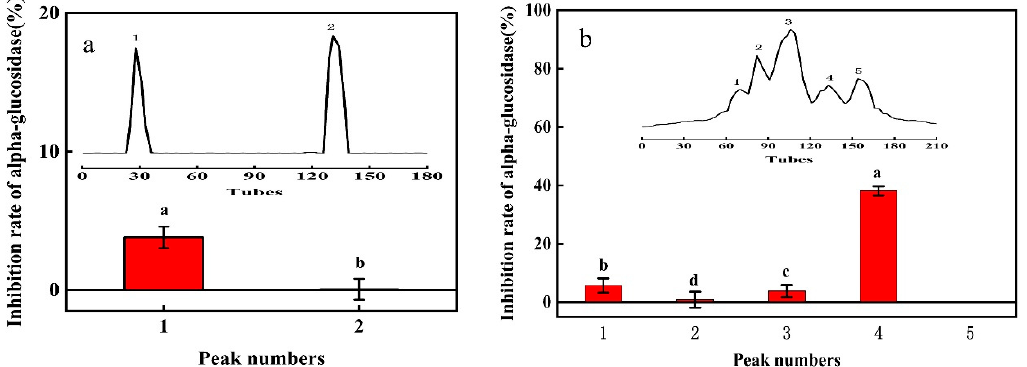
Figure 2. ( a ) Chromatogram (insert) and α -glucosidase inhibitory activity of bioactive peptides purified with a DEAE Sepharose fast flow ion column. ( b ) Chromatogram (insert) and α -glucosidase inhibitory activity of bioactive peptides purified with a Sephadex G-25 column.